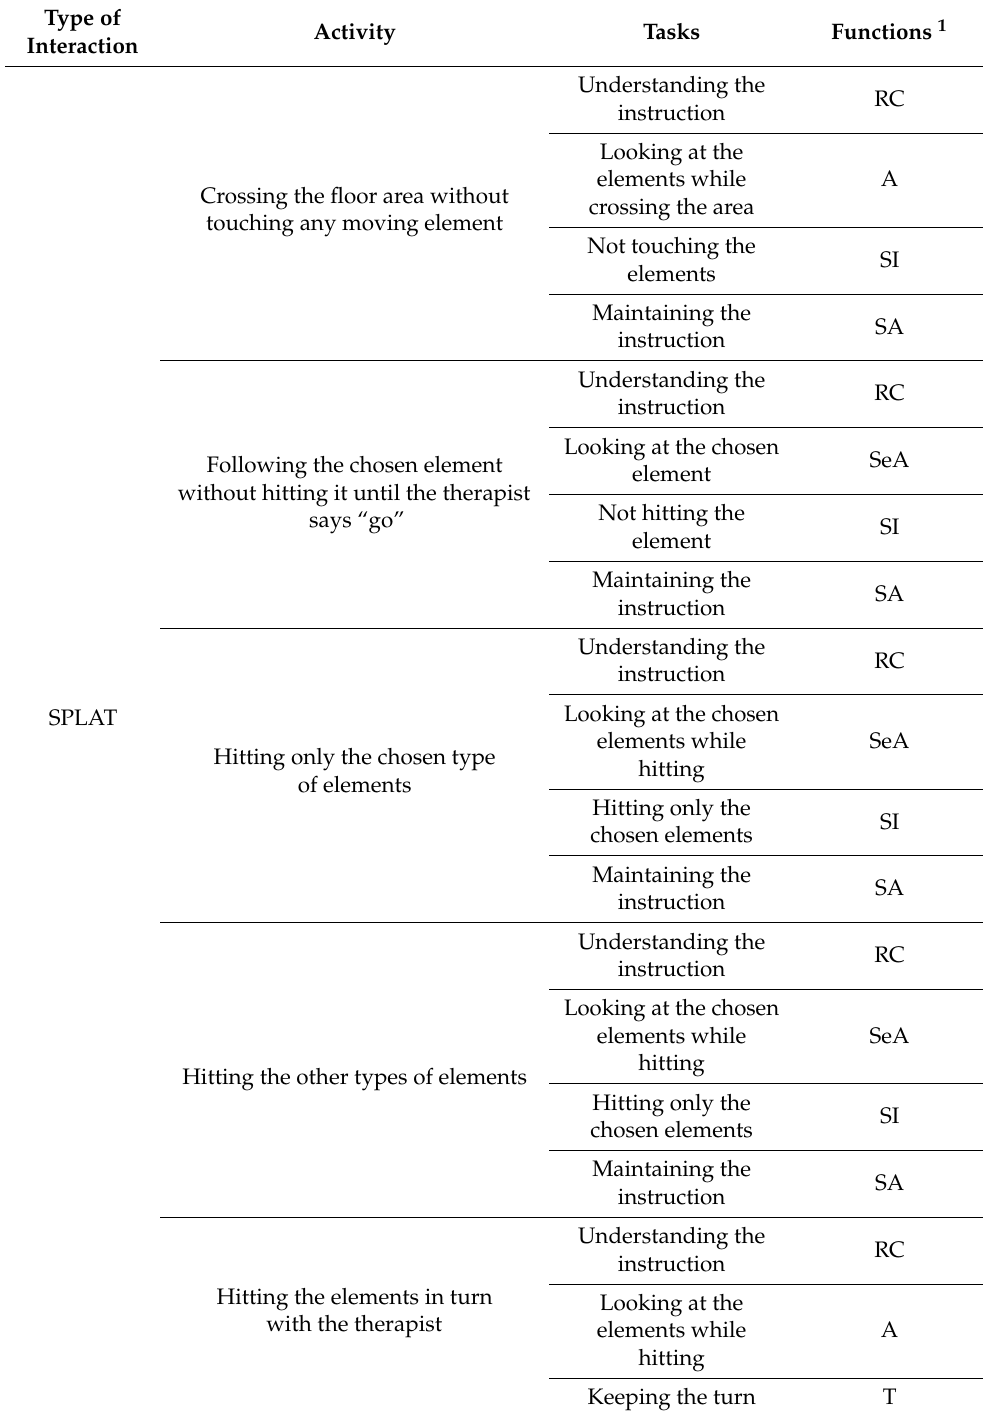
Table A1. Protocol used with the high-functioning